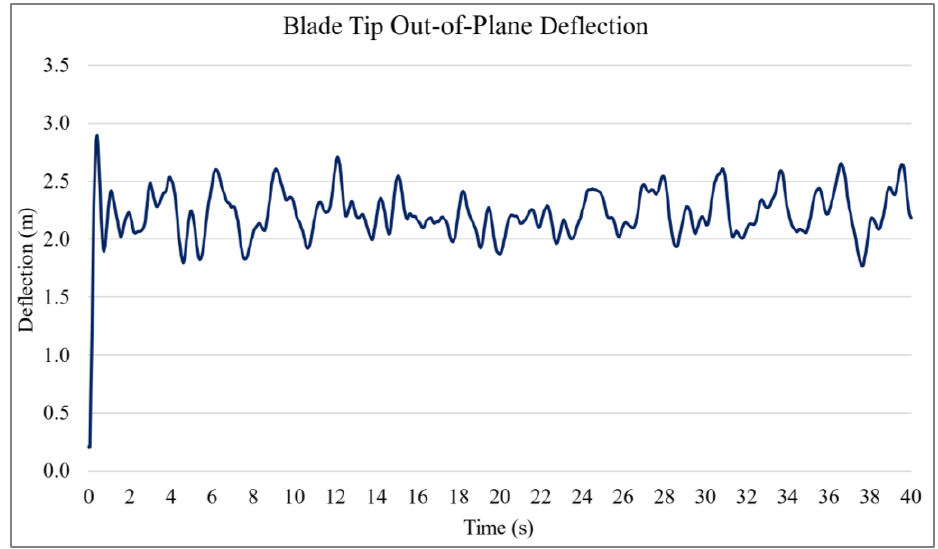
Figure 5. Blade Tip Out-of-Plane Deflection - 10% Turbulence Intensity